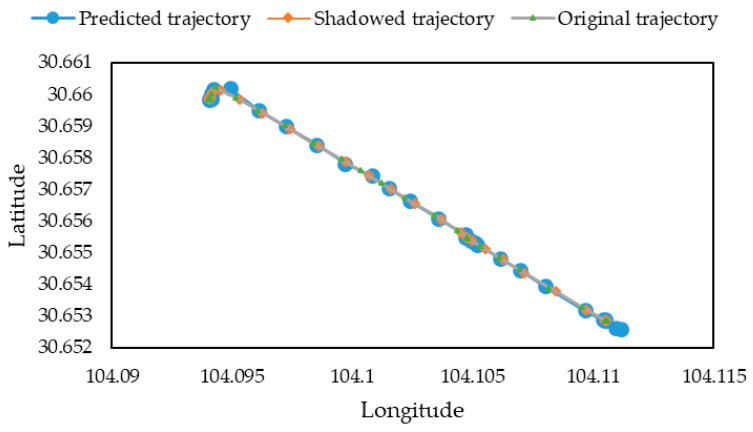
Figure 16. The original, shadowed, and predicted trajectories of the taxi for the marked (a).